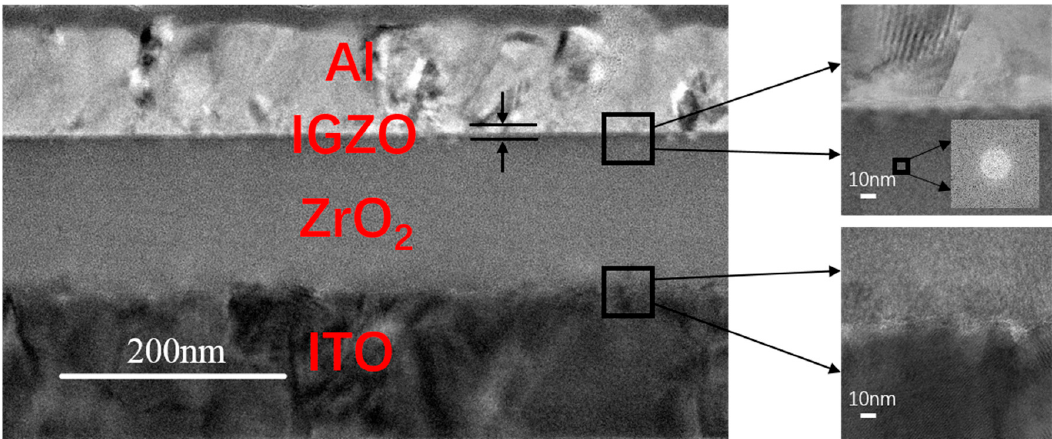
Figure 6. Effect of precursor concentration of film formation.